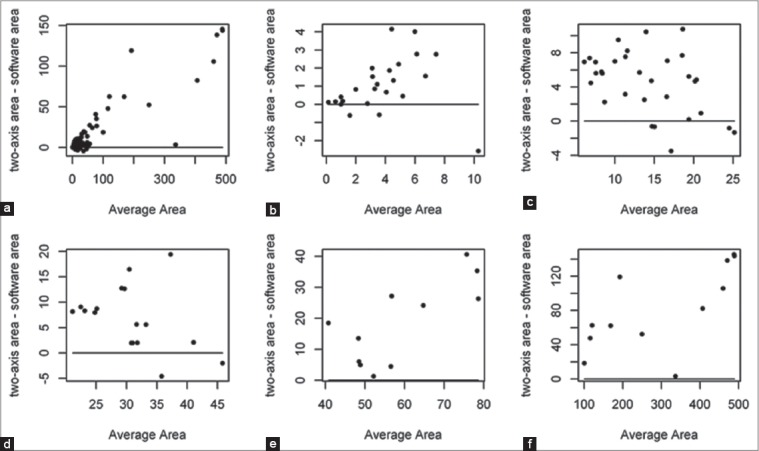
Comparison of area measurement between two-axis and software methods. Panel A: Overall wound area measures; Panel B: Two-axis wound area measures <10 cm2; Panel C: Two-axis wound area measures ≥10 cm2 and <25 cm2; Panel D: Two-axis wound area measures ≥25 cm2 and <50 cm2; Panel E: Two-axis wound area measures ≥50 cm2 and <100 cm2; Panel F: Two-axis wound area measures ≥100 cm2. An increasing trend for the discrepancy between the two methods with the increasing of the wound area is shown.